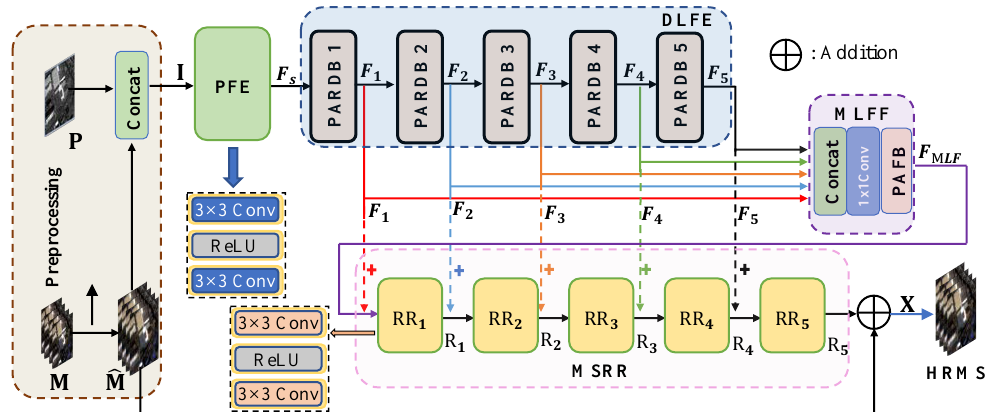
Figure 1. Diagram of